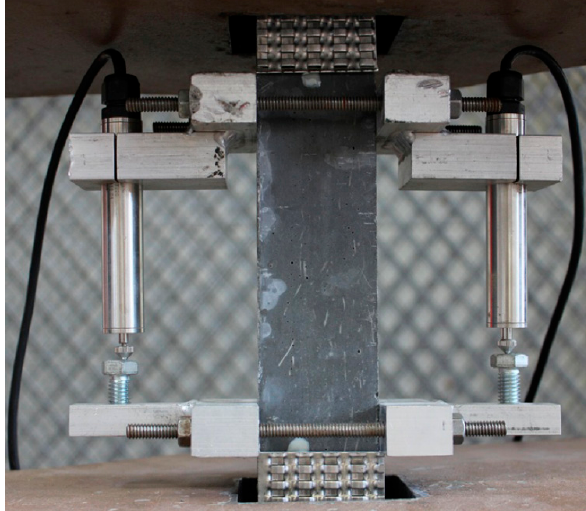
Figure 6. Test set-up for the uniaxial tensile test of UHPC [7].